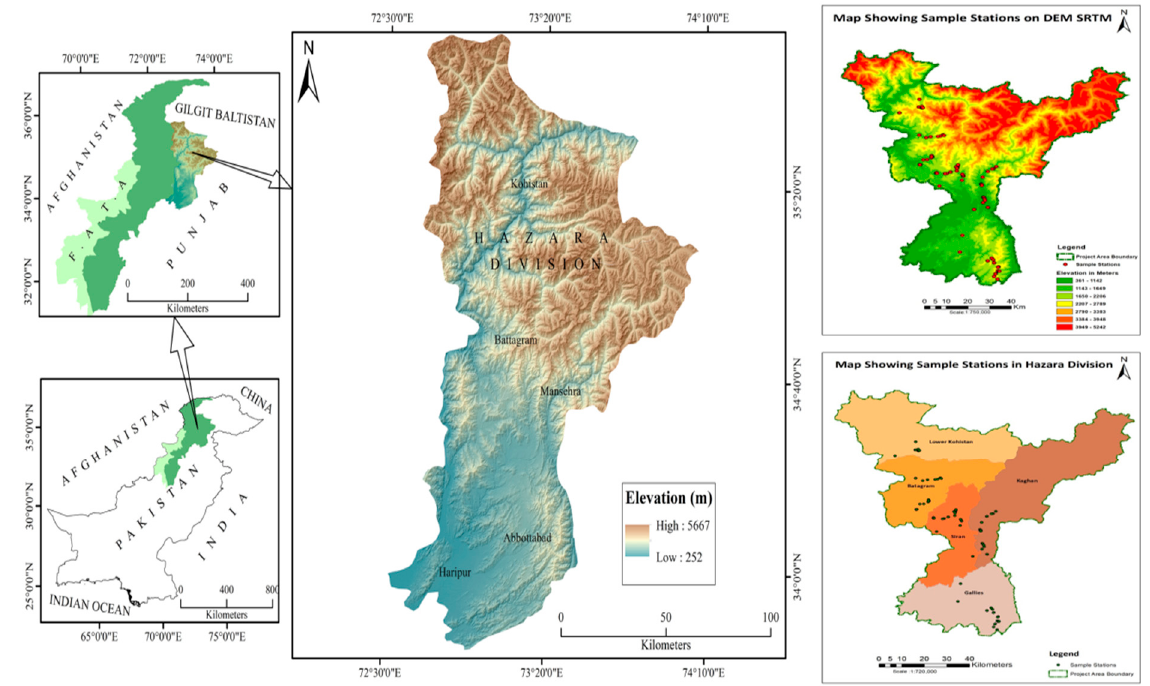
Figure 1. GIS generated map of Hazara Division, western Himalayas indicating to neighboring regions. Sampling plots of U. villosa are represented with dots. Table 1. List of barcoding genes used for Polymerase Chain Reaction (PCR) and sequencing with experimentally optimized amplification